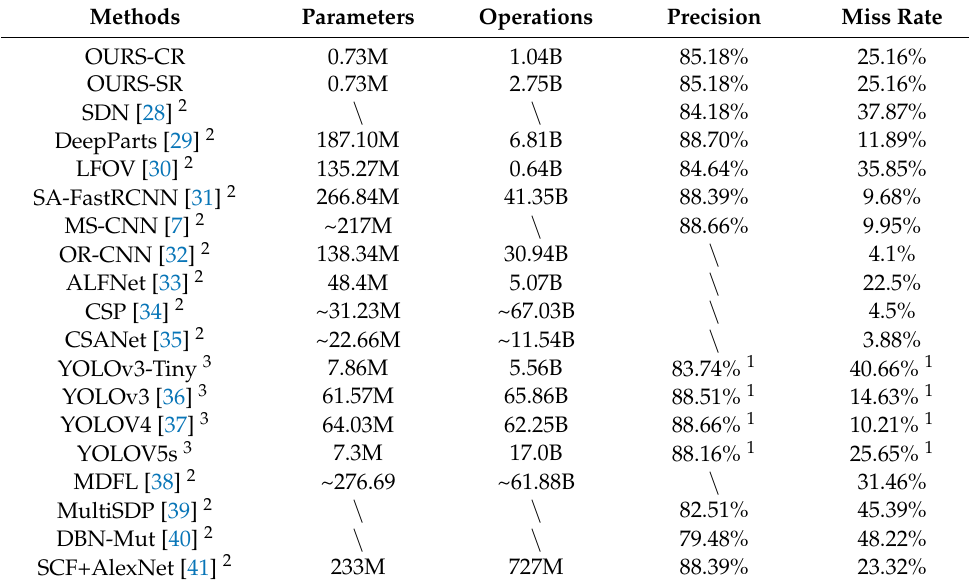
Figure 9. The miss rate curve of the proposed method and the comparison with the existing methods. Table 4. Computation complexity comparison of different